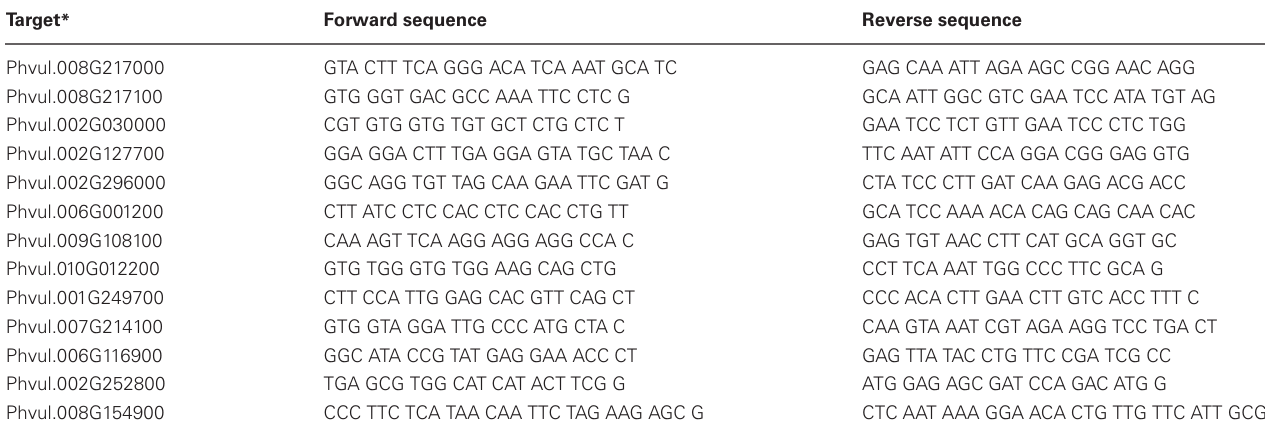
Table 1 | List of oligonucleotides used in this work.